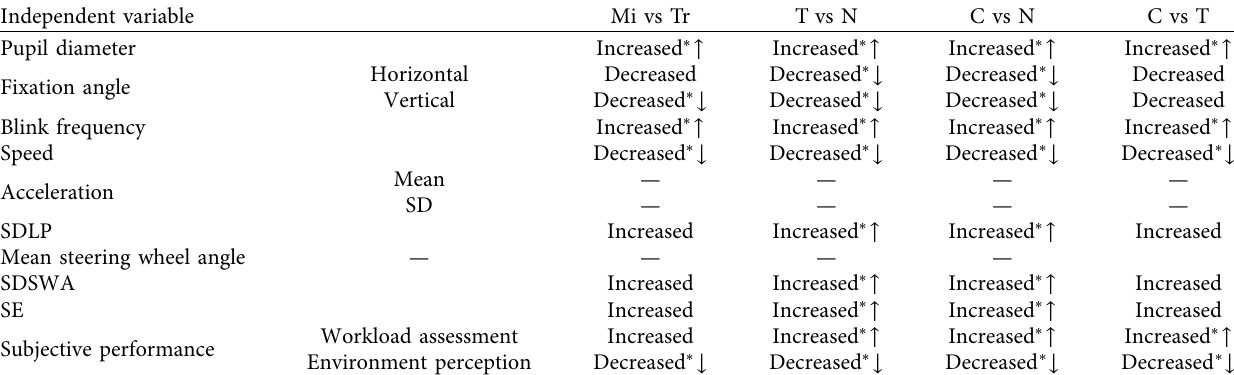
Table 5: Results of analyses of driver physiological measures and driving performance parameters. Independent